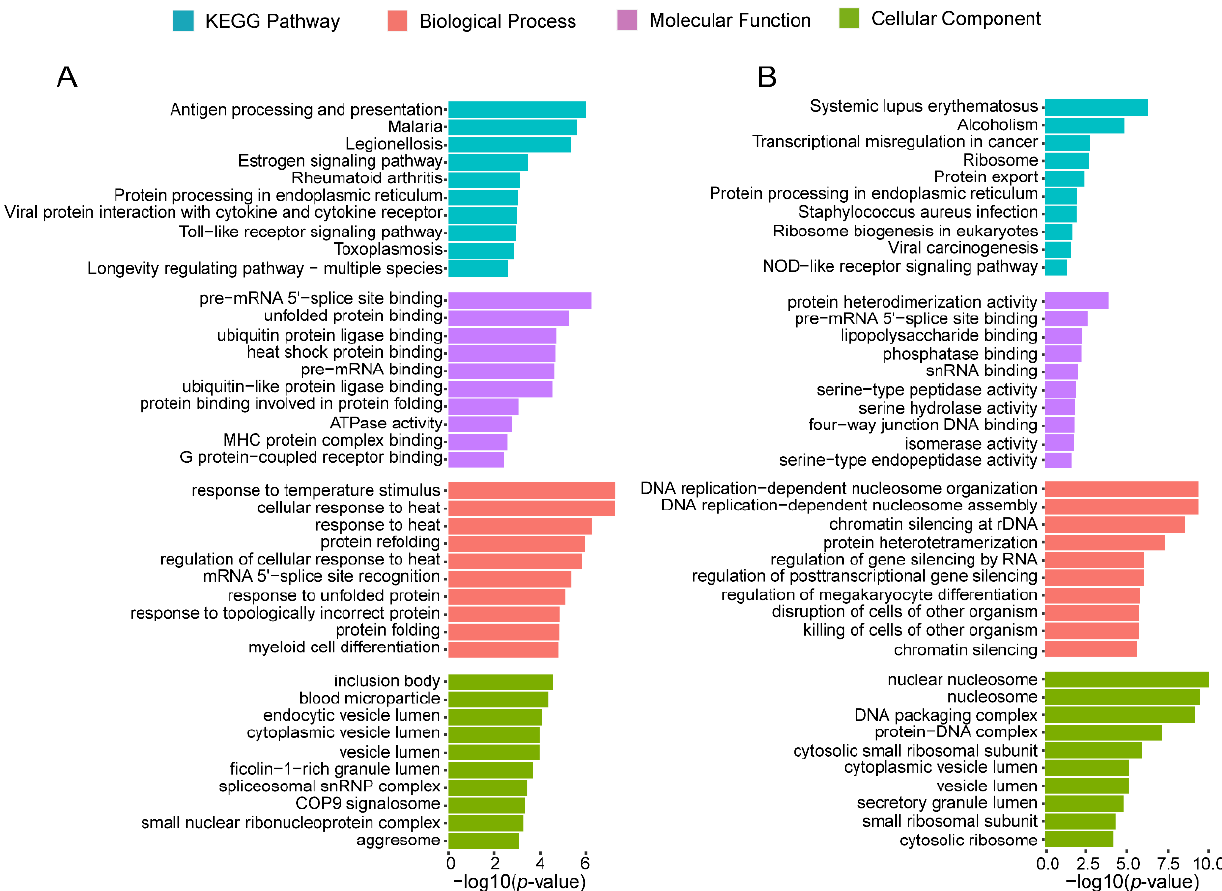
Figure 4. Functional enrichment of c-CCMs-related genes . ( A , B ) Functional classification of genes strongly (r > 0.75) co-expressed with LLI-gained and -lost c-CCMs. Top 10 KEGG pathways are shown. ( A ) LLI-gained c-CCMs. ( B ) LLI-lost c-CCMs.